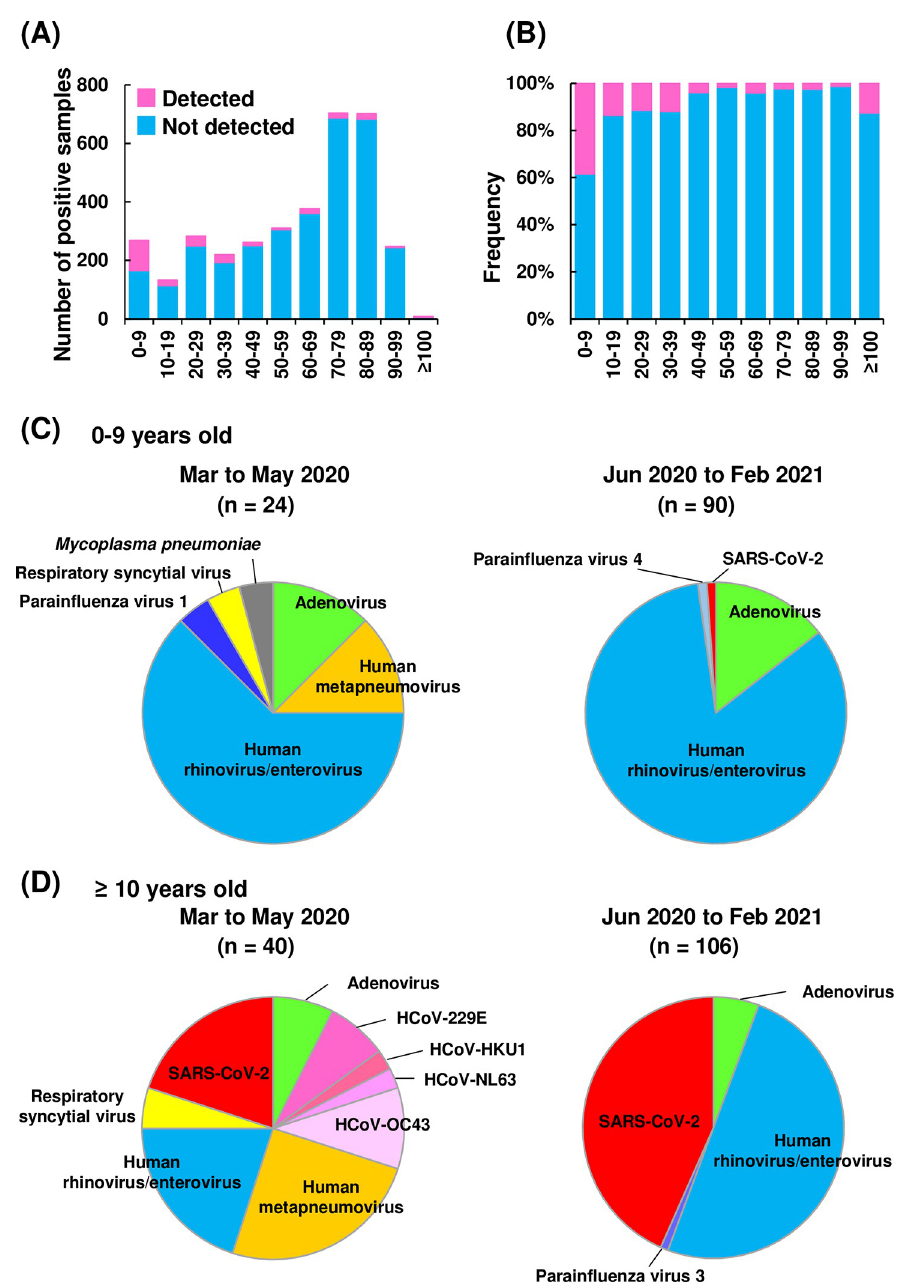
Fig 3. Respiratory-related pathogen infections by age group. (A) Number of positive samples in each age group. Bar plots indicate samples in which at least one pathogen was detected (pink) and samples in which none were detected (light blue). (B) Percentage of positive samples in each age group. The graph shows the number of positive samples detected in each age group divided by the total number of samples tested. The percentages were calculated based on the data in (A). (C, D) Pie charts show the pathogens detected during the period of March to May 2020 and June 2020 to February 2021. Age group represents data from 0–9 years (C) and 10 years and older (D). The number of positive samples were noted above the pie